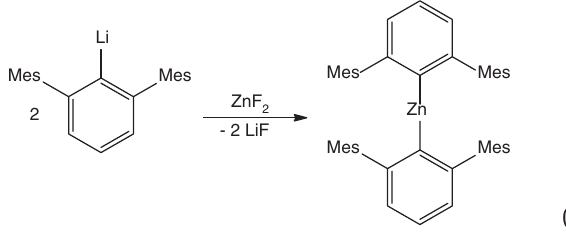
Figure 1. Selected geometrical parameters are collected in Table 1, along with known monomeric diarylzinc com- pounds for